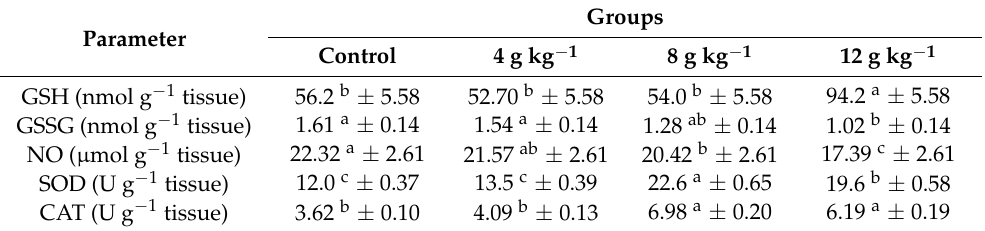
Table 7. Means ± standard errors for liver oxidative stress markers of growing ducks are supported by S. marianum dry seeds at different levels (4, 8, and 12 g kg − 1 diet) and control during brooding.